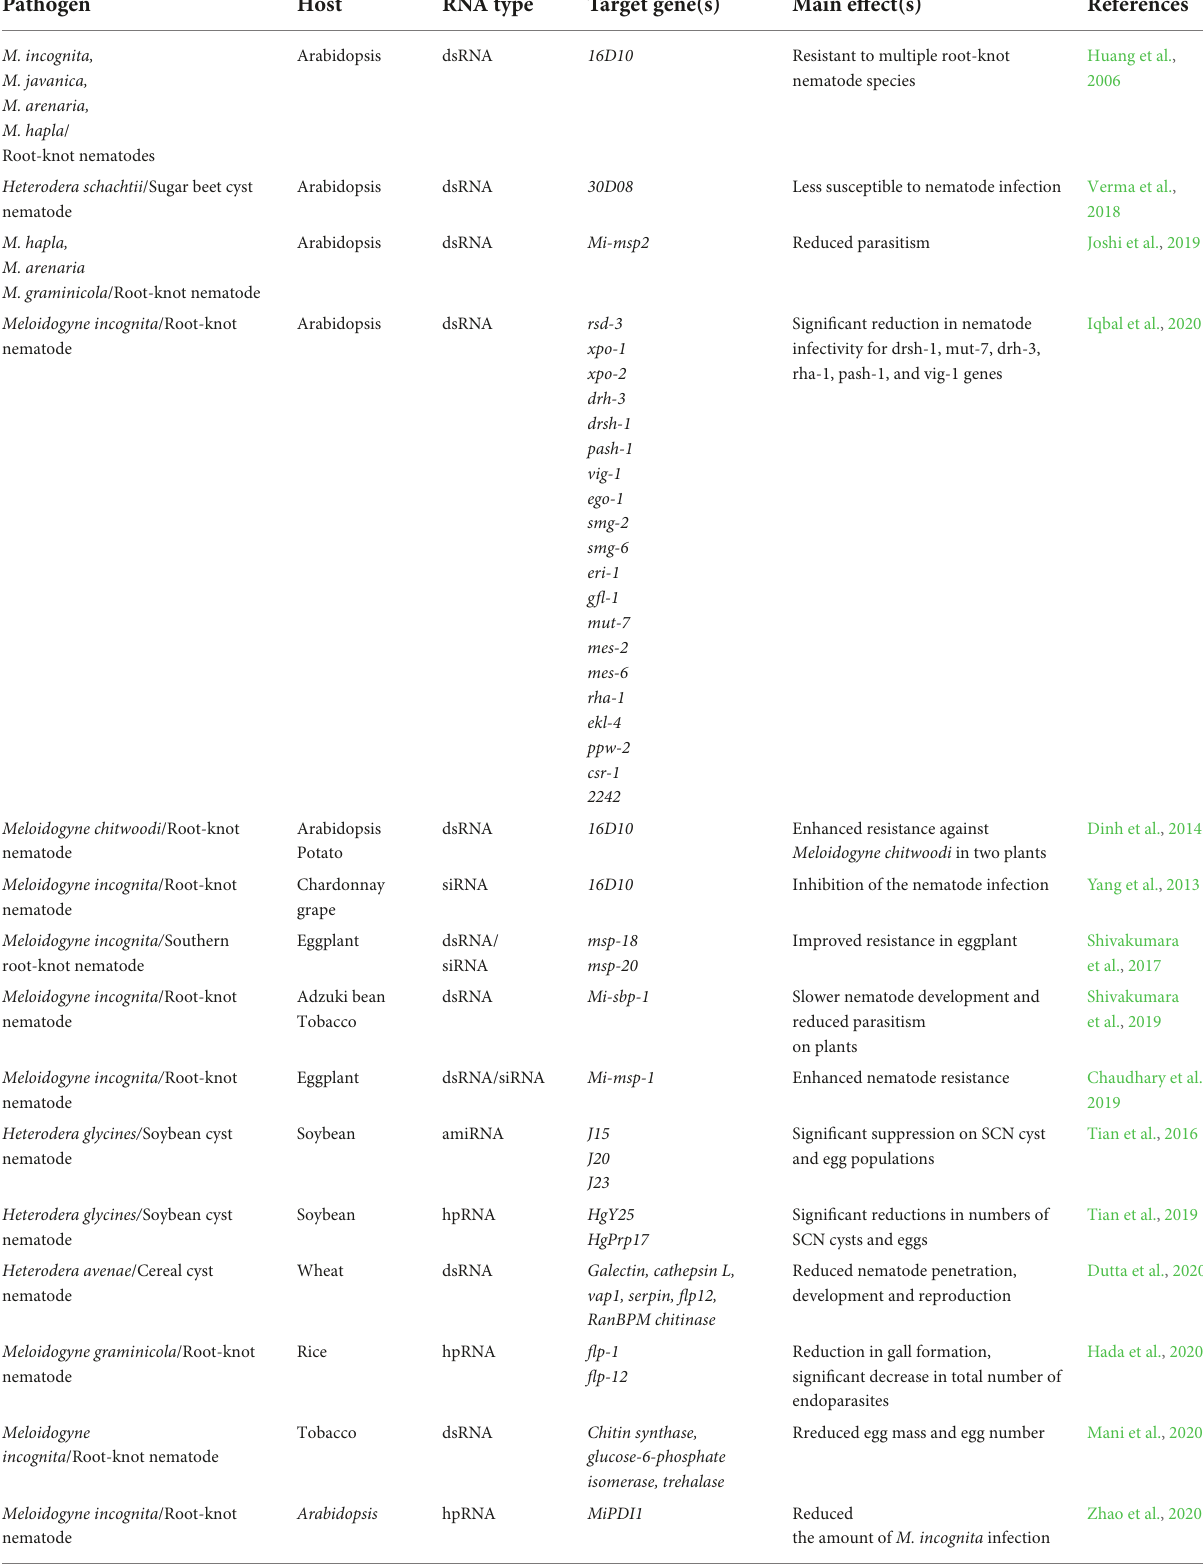
TABLE 4 Summary of HIGS application for control of